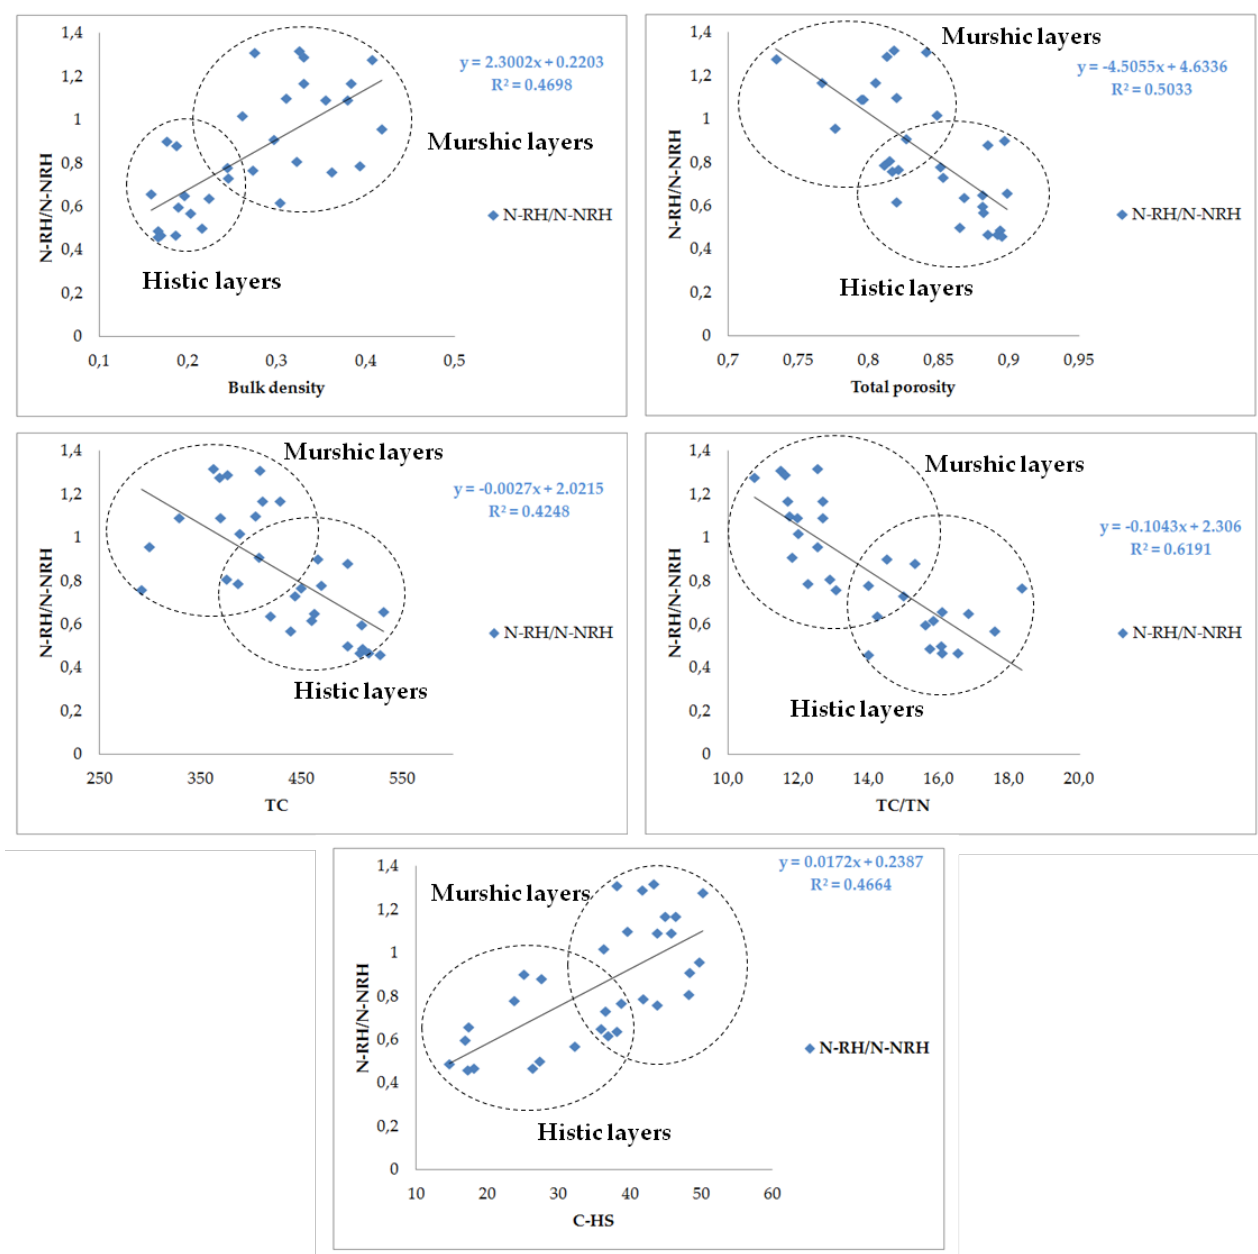
Figure 2. Relationship between the ratio of readily hydrolyzable to non-readily hydrolyzable nitrogen (N RHON /N NRHON ) and the chosen physical and chemical properties of the soil.